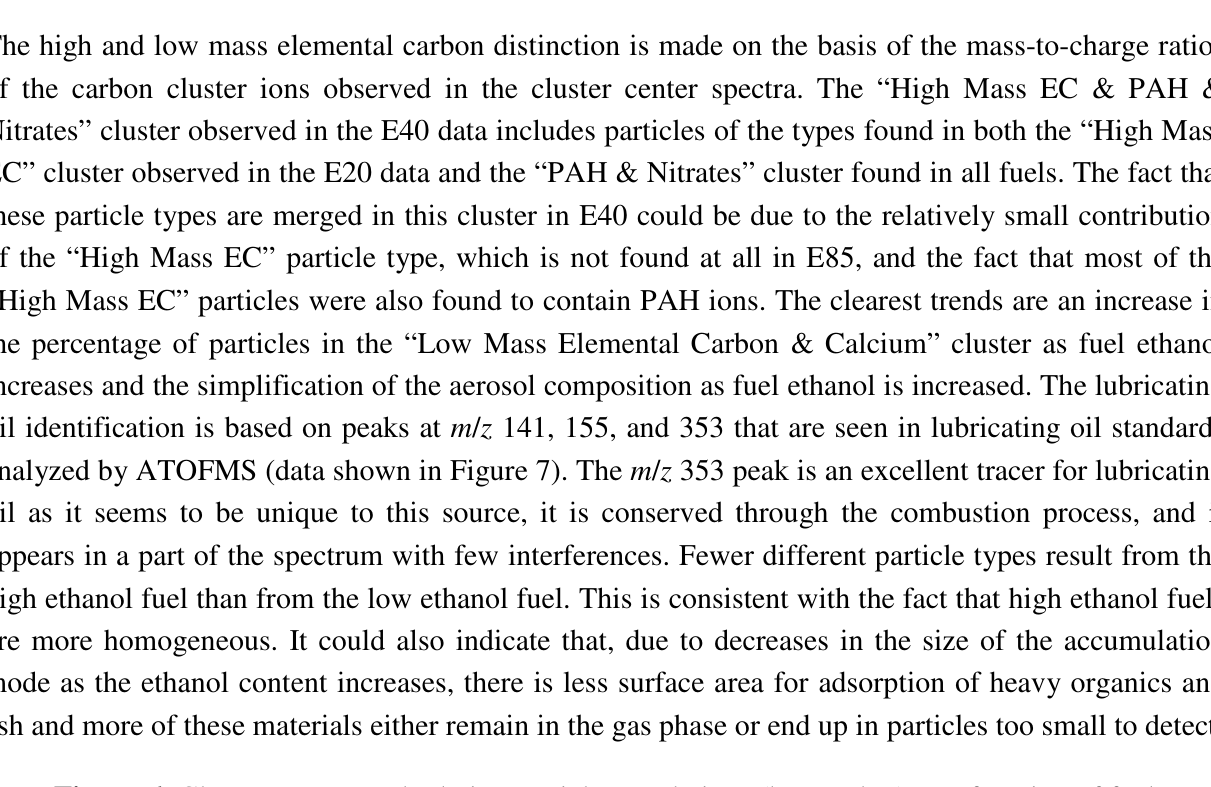
Figure 6. Cluster centers and relative particle populations (by number) as a function of fuel type for the combined data from both ATOFMS